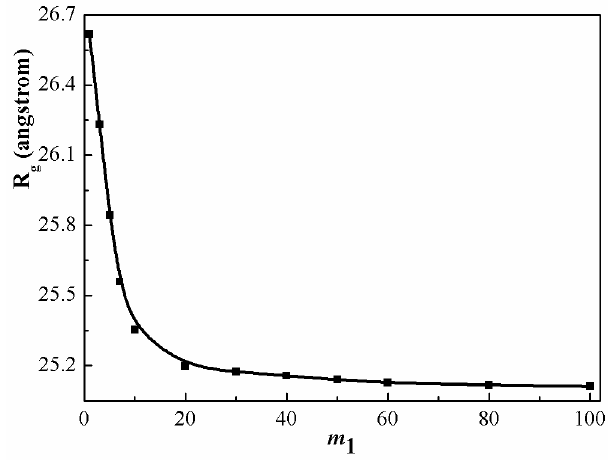
= ) as a function of chain length of short chain PS